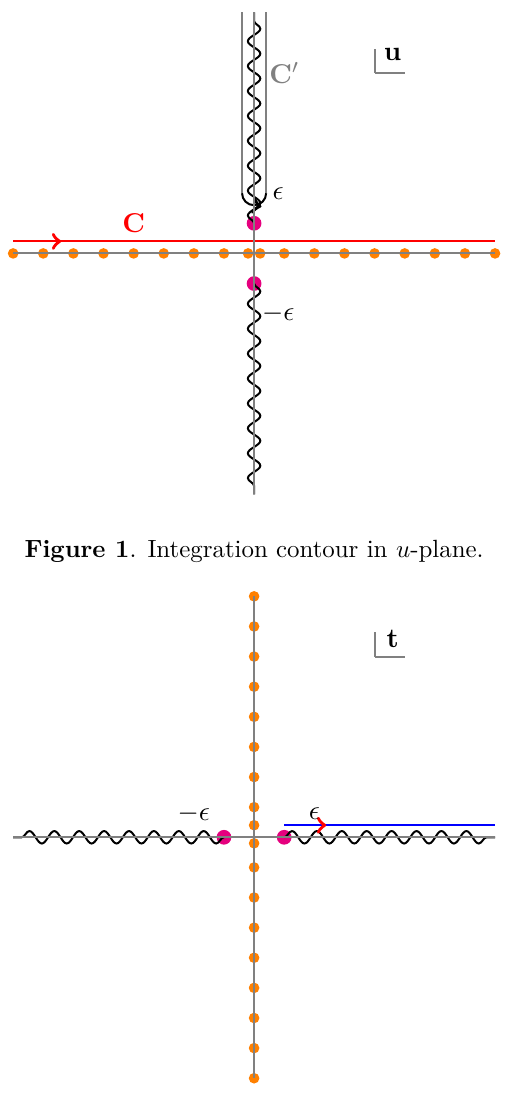
Figure 2 . Integration contour in t